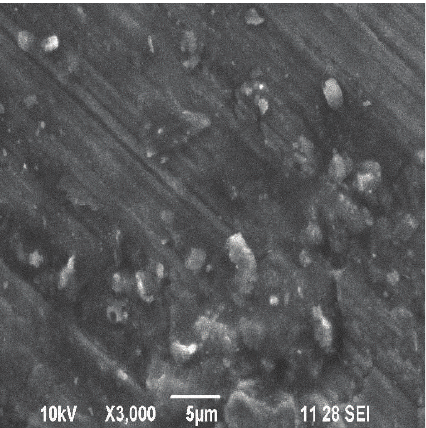
Figure 5: SEM of sample-II (10wt% of WSD particles). Figure 6: SEM of sample-III (20wt% of WSD